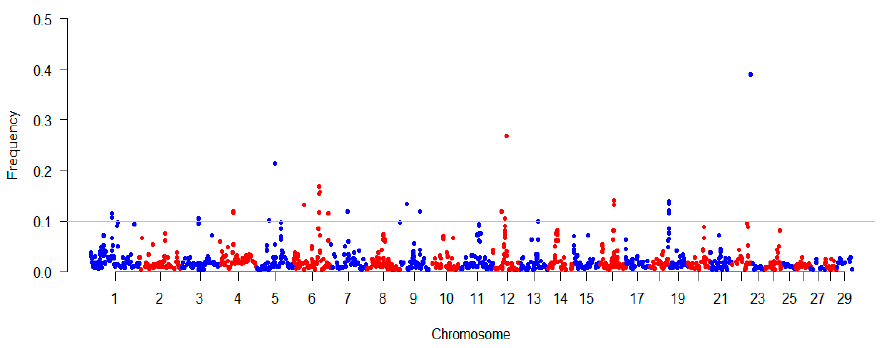
Figure 1. ( a ) The total numbers and lengths of runs of homozygosity (ROH) of three classes including Small (0.5 to 1 Mb), Medium (1 to 5 Mb), and Large ( > 5 Mb) classes. ( b ) Correlation of total ROH numbers and lengths. The ROH number ( y -axis) is plotted against the ROH length ( x -axis, i.e., the length of Mb covered by ROH) in each individual.